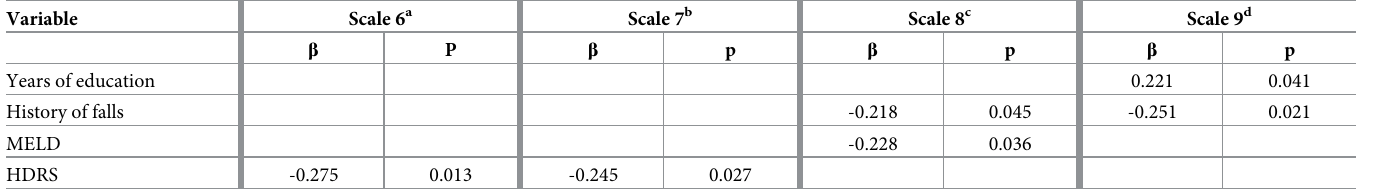
Table 5. Multivariable analyses of risk factors of HLQ subscales 6–9, which were found significant in univariable